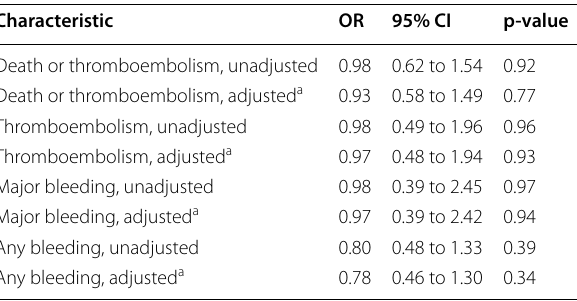
LMWH, Fibrin-D-dimer, and CRP There were considerable uncertainties in the analyses when separately analyzing patients with high, interme- diate, and low dosing of LMWH against dose of dexa- methasone (Additional file 2: Table S3). Interactions between the intervention and both fibrin-D-dimer and CRP were investigated for all out- comes with no statistically significant different result and substantial uncertainty in the results (Additional file 2: Fig S1).